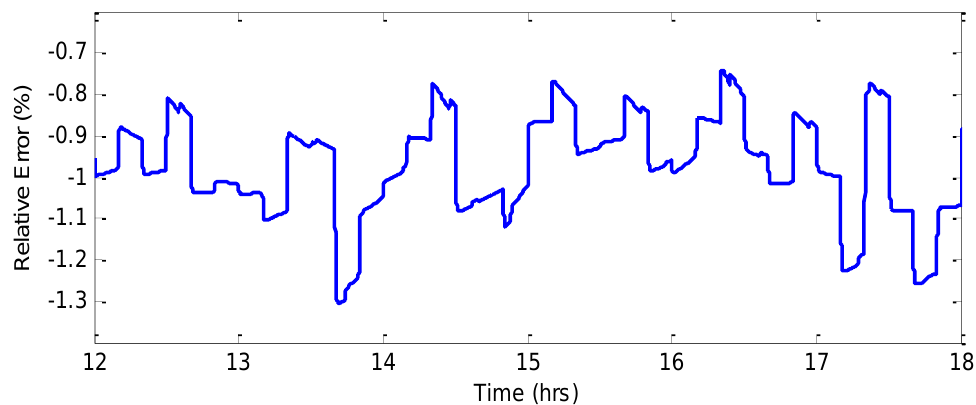
Figure 9. Plots of the simulated and tested heat inlet rate as well as the electrical load vs. time.